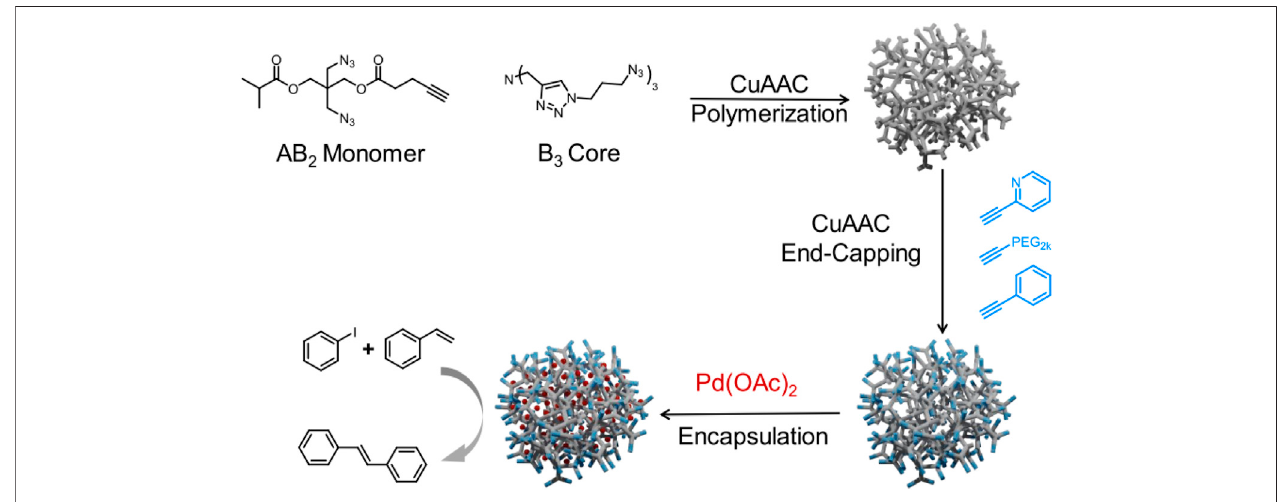
FIGURE 8 | Heck reaction to synthesize hyperbranched polymers (Gan et al., 2020).